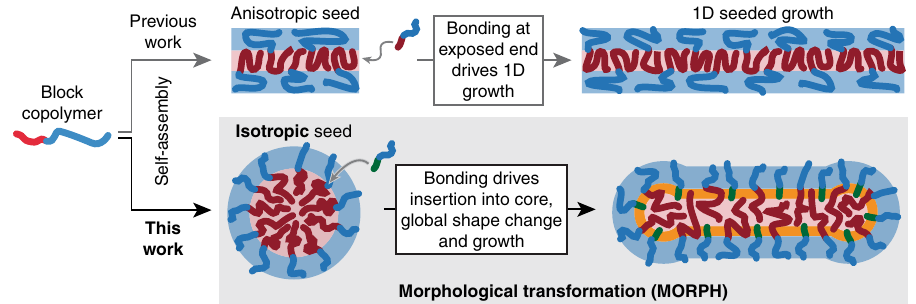
Fig. 1 Methods for the growth of anisotropic polymer nanostructures with controlled dimensions. Previous efforts have been based on 1-dimensional growth from an anisotropic seed particle (top). We report a qualitatively different process based on the global morphological transformation of an isotropic seed particle